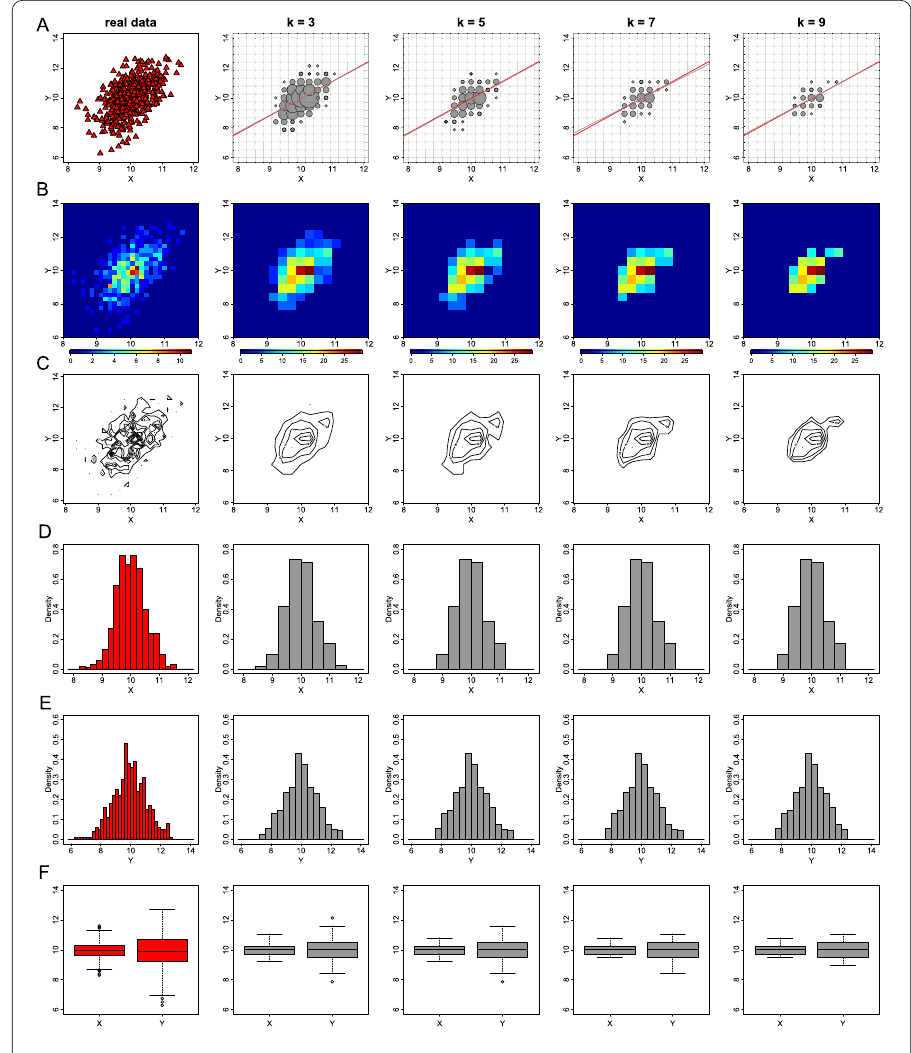
Figure 9 The effect of parameter k of the k -anonymization method on exploratory data visualizations with additional generalization. From left to right we demonstrate the effect of k for the values of 1 (this is equivalent to the real data), 3, 5, 7 and 9 on generating privacy-preserving scatter plots ( A ), heat map plots ( B ), contour plots ( C ), histograms of X ( D ) and Y ( E ), and box plots ( F